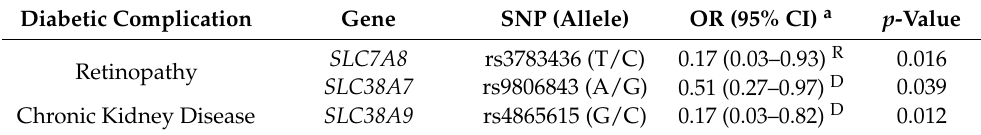
Table 3. SNPs associated with diabetic microvascular and macrovascular